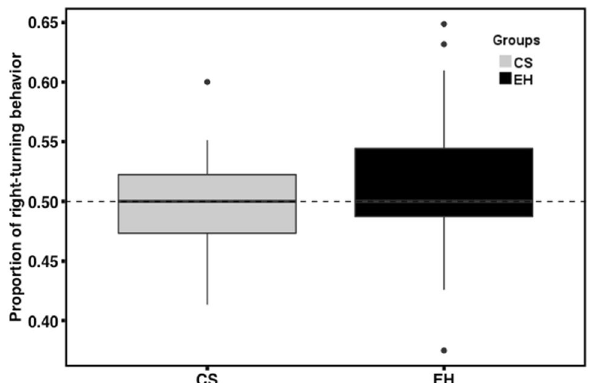
Figure 4. Comparison of proportion of turning bias between groups. The solid line indicates the median. The bottom of the box represents the first quartile (25th percentile) and the top of the box represents the third quartile (75th percentile). Whiskers represent the lower and upper bound for data excluding